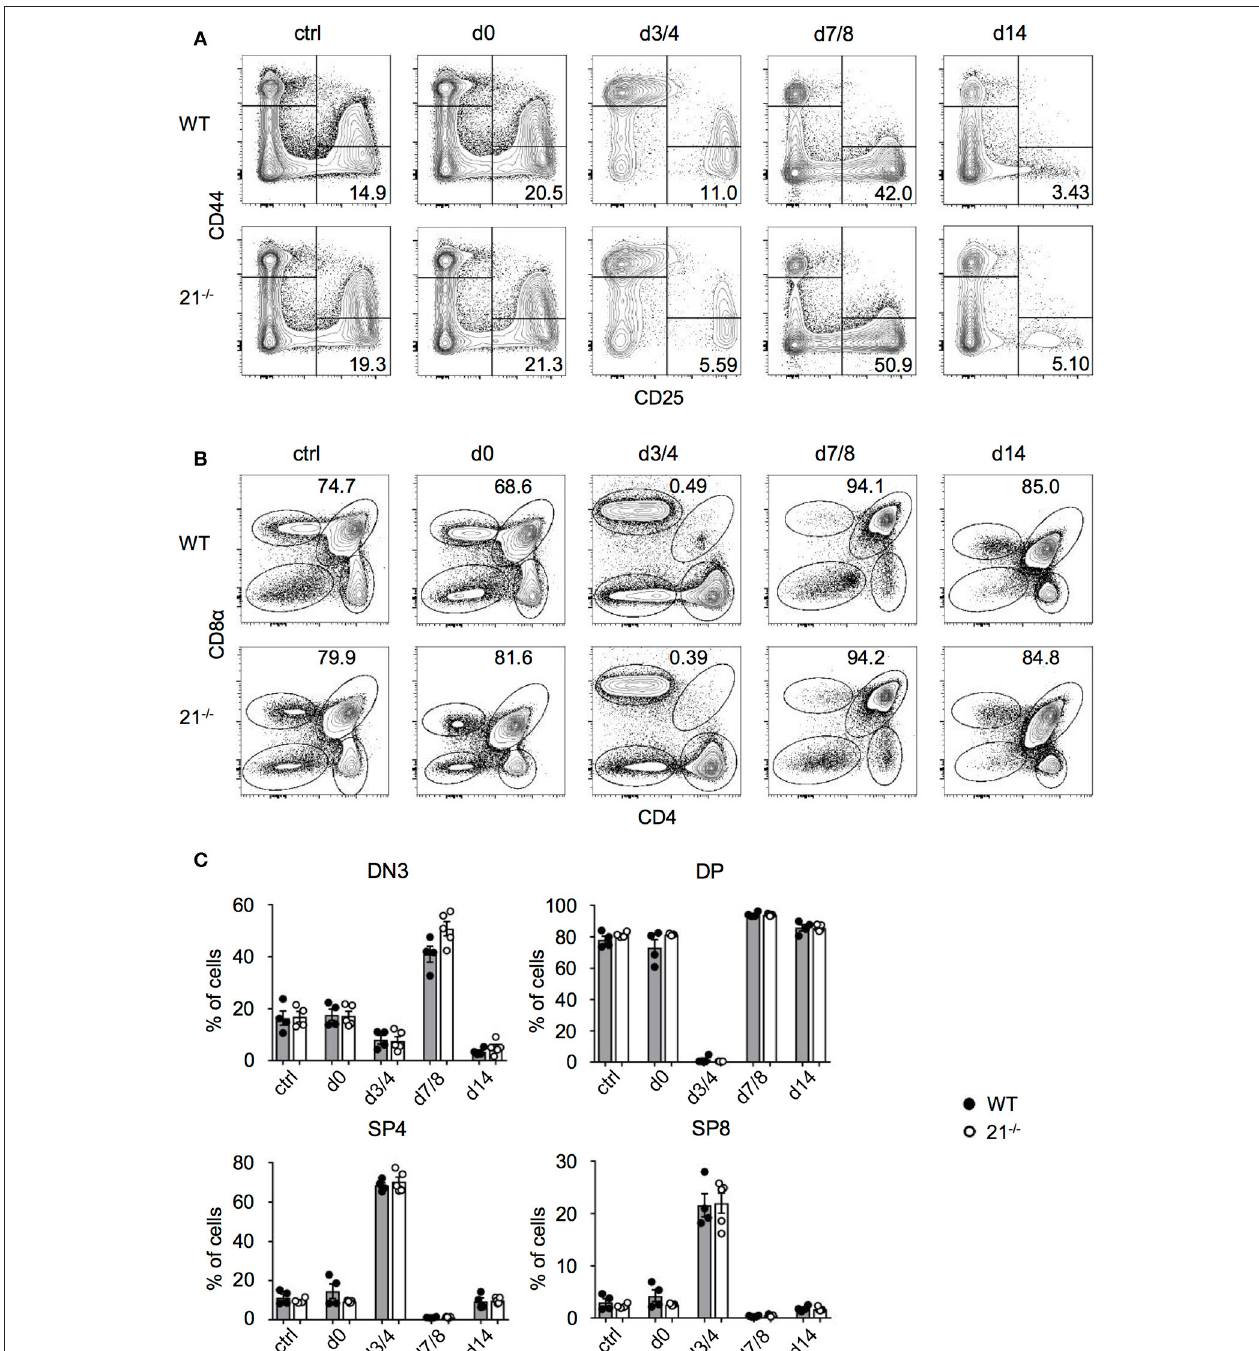
FIGURE 7 | Loss of miR-21 does not affect endogenous T-cell regeneration. (A) Representative flow cytometric analysis of thymi from WT and miR-21 − / − mice stained with antibodies against CD25 and CD44. Numbers in right bottom quadrants represent frequencies of DN3 thymocytes. Regeneration of DN thymocytes was assessed at indicated periods of time in non-irradiated mice or post sublethal irradiation. Pooled data of two independent experiments. (B) Representative flow cytometric analysis of thymi from WT and miR-21 − / − mice stained with antibodies against CD4 and CD8 α . Numbers adjacent to right gate represent frequencies of DP thymocytes. Regeneration of DP, SP4, and SP8 thymocytes was assessed at indicated periods of time in non-irradiated mice or post sublethal irradiation. Pooled data of two independent experiments. (C) Statistical analysis of flow cytometric results shown in (A,B) . Each dot represents one mouse, n = 4-5 per genotype. Statistical analysis were performed using unpaired Mann-Whitney